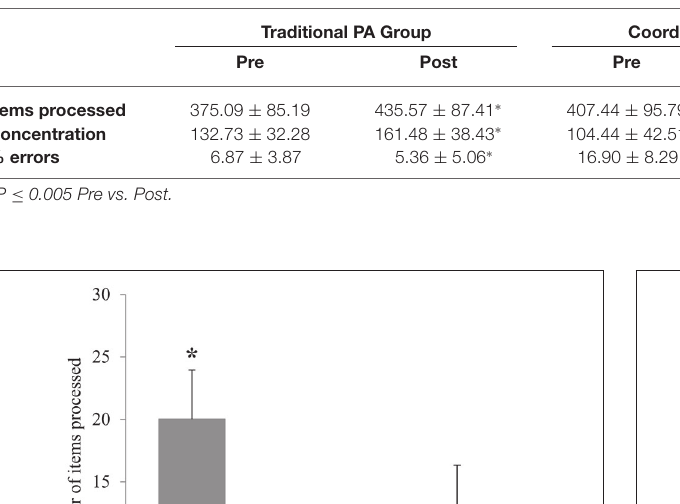
TABLE 3 | Pre- and post-PA intervention individual scores (mean ± SD) for items processed, concentration, and % errors.